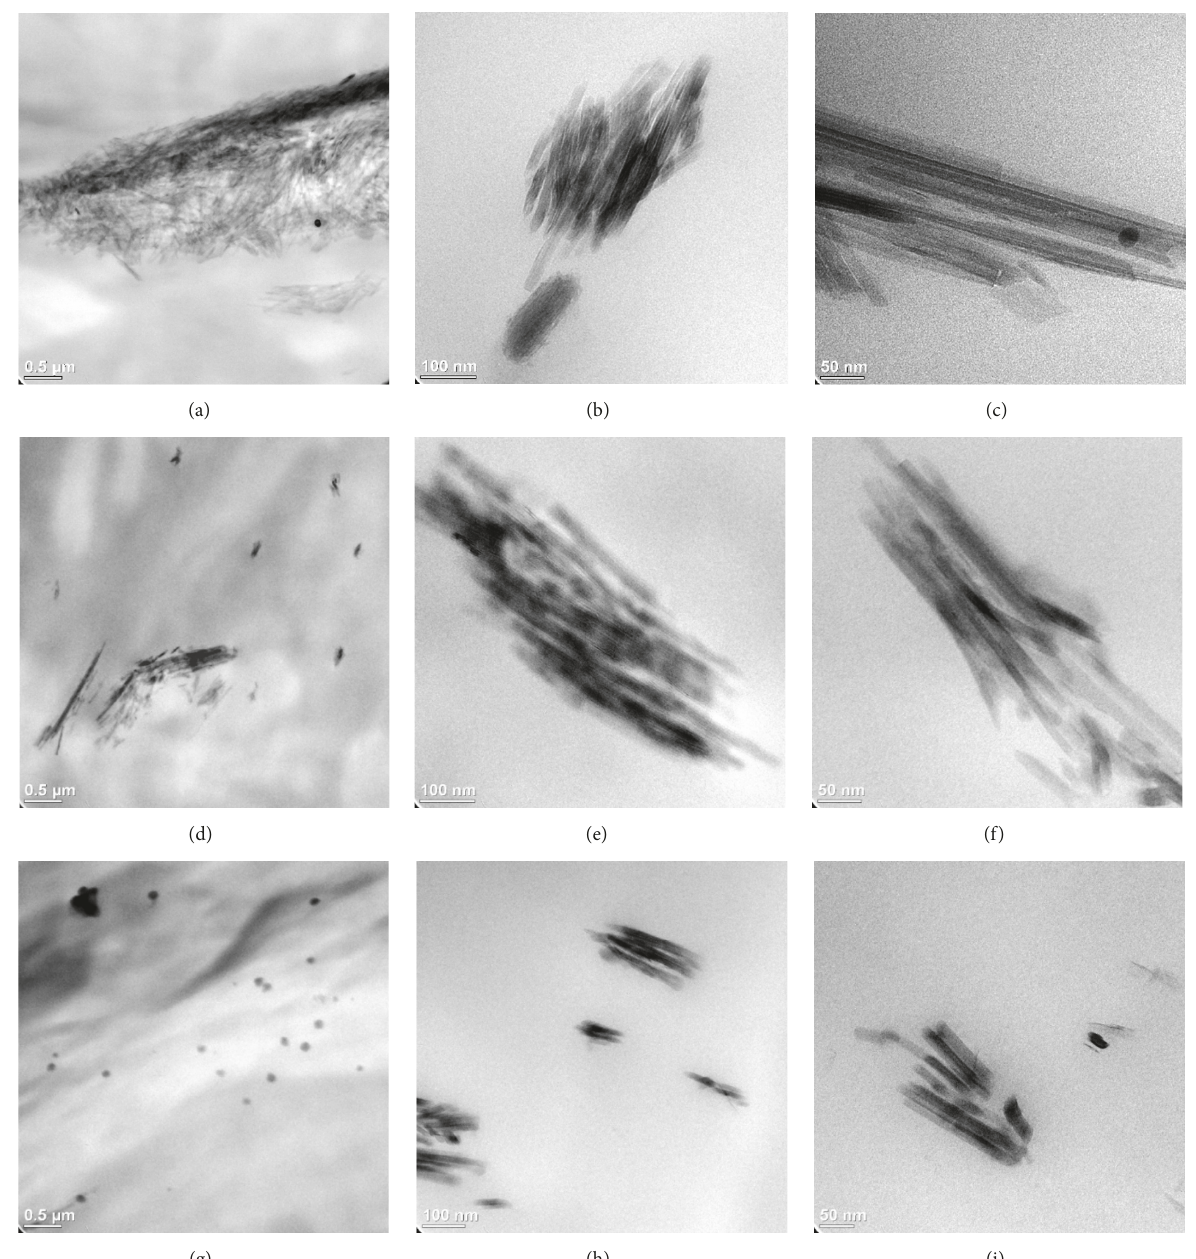
Figure 5: TEM micrographs of PP/PP-g-MAH/Pal nanocomposites: Pal-1 ((a) to (c)), Pal-2 ((d) to (f)), and Pal-3 ((g) to